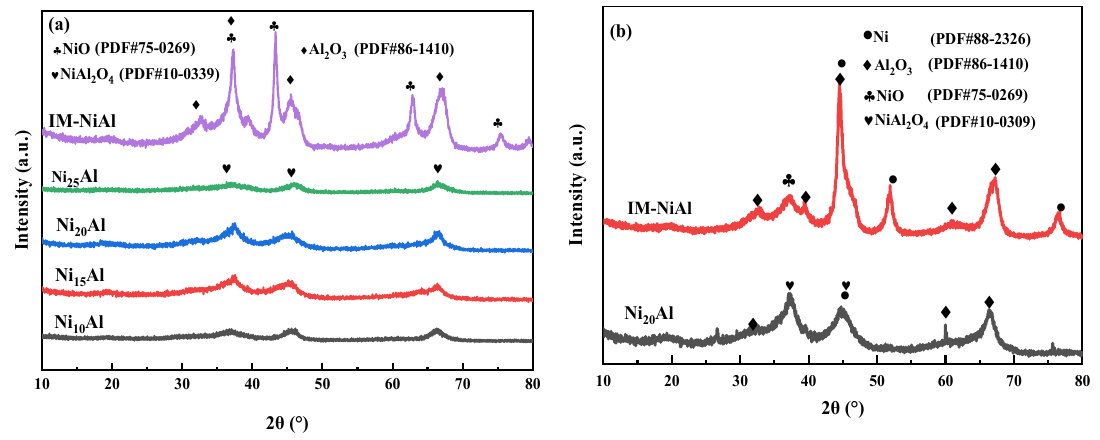
Figure 2. XRD patterns of Ni x Al and IM-NiAl catalysts: ( a ) after calcination and ( b ) after reduction.